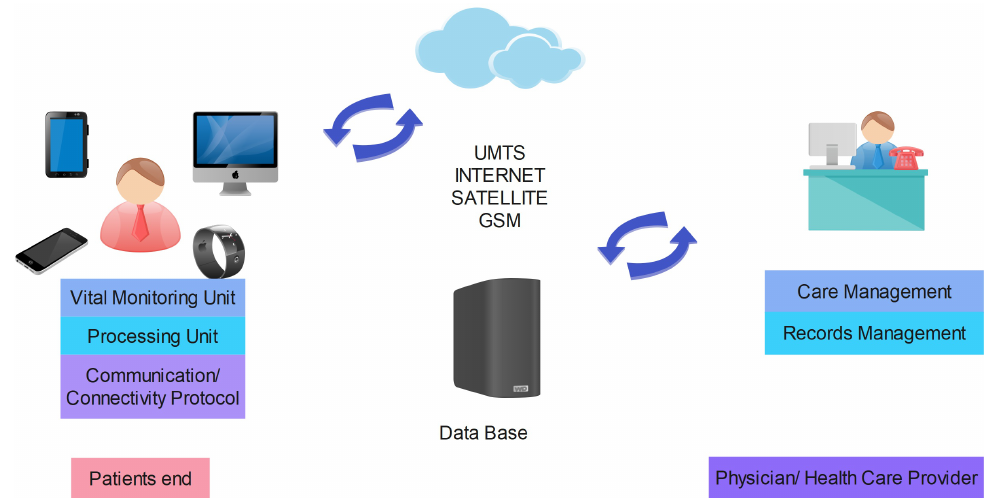
Figure 1. Telemedicine Systems